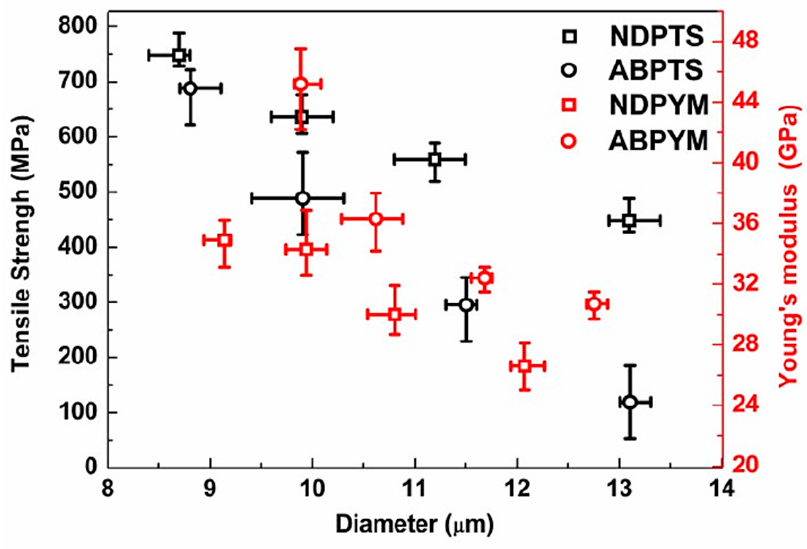
Figure 9. The mechanical properties of NDP-CF and ABP-CF.